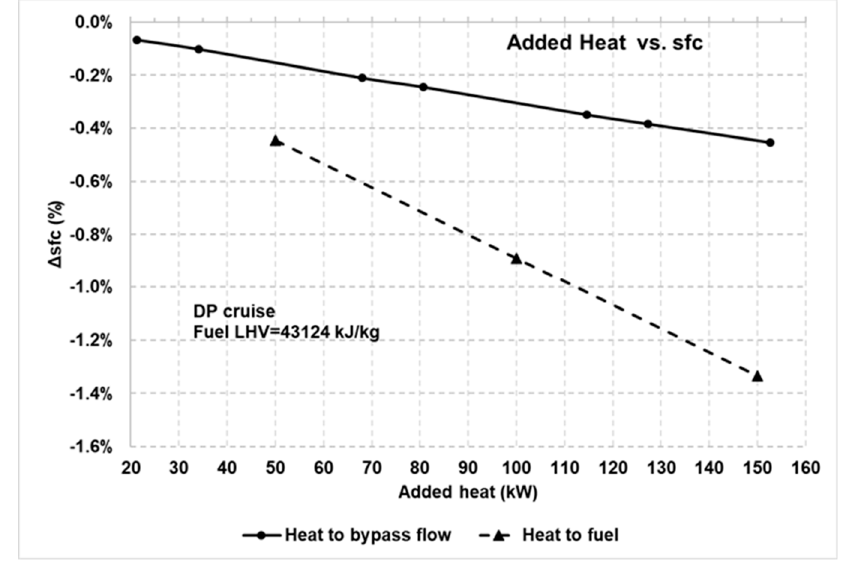
Figure 14. Added heat effect on SFC (DP study).